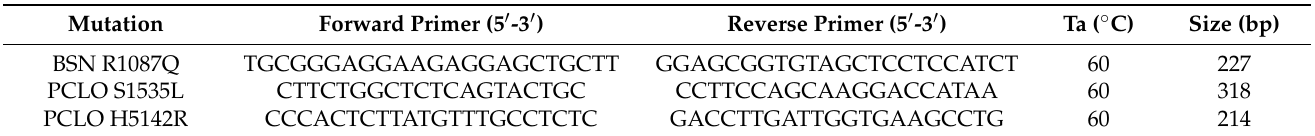
Table 1. Primer sequences, optimal annealing temperature (Ta), and amplicon size of Sanger sequencing for verification of the mutations identified in this study.